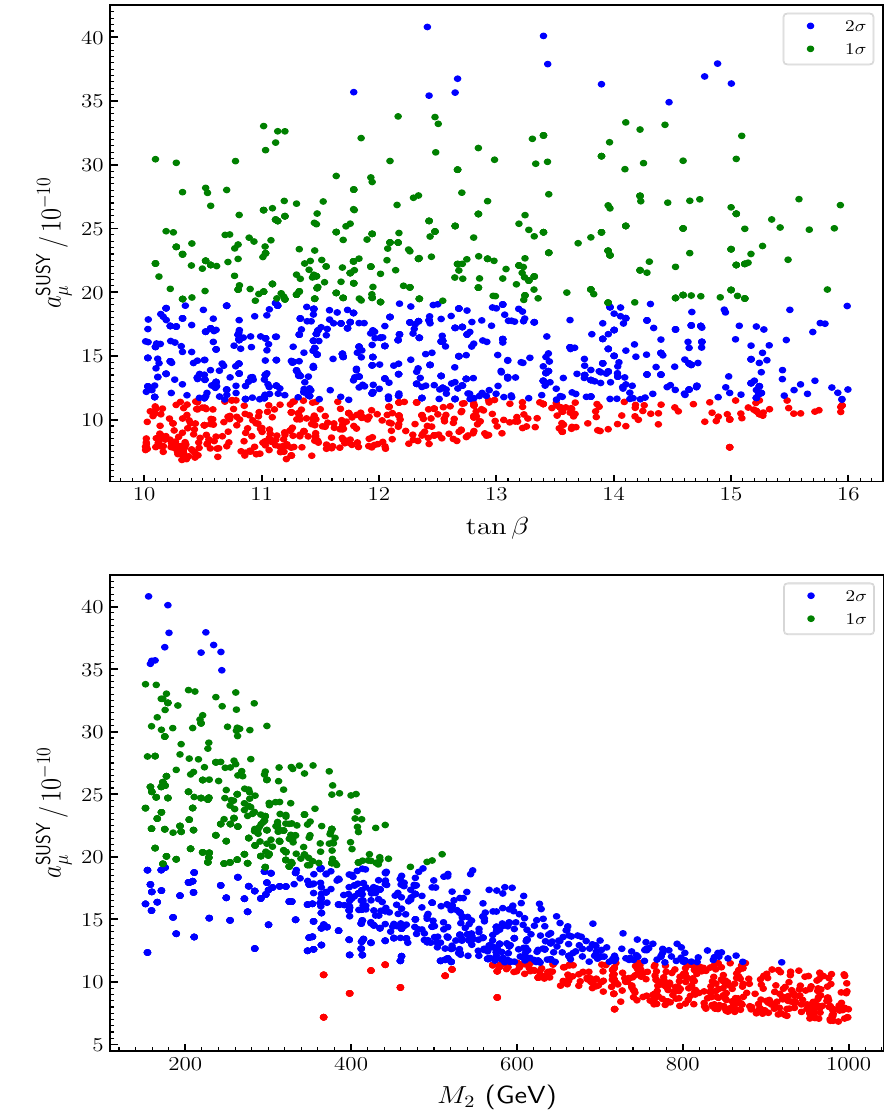
Fig. 6 a SUSY μ versus tan β from the scan of Tables 2 and 3. The green and blue colors represent points in the 1 σ and 2 σ regions of (cid:3) a μ in Eq. (1), respectively. The red points are not within the 2 σ cut on (cid:3) a μ